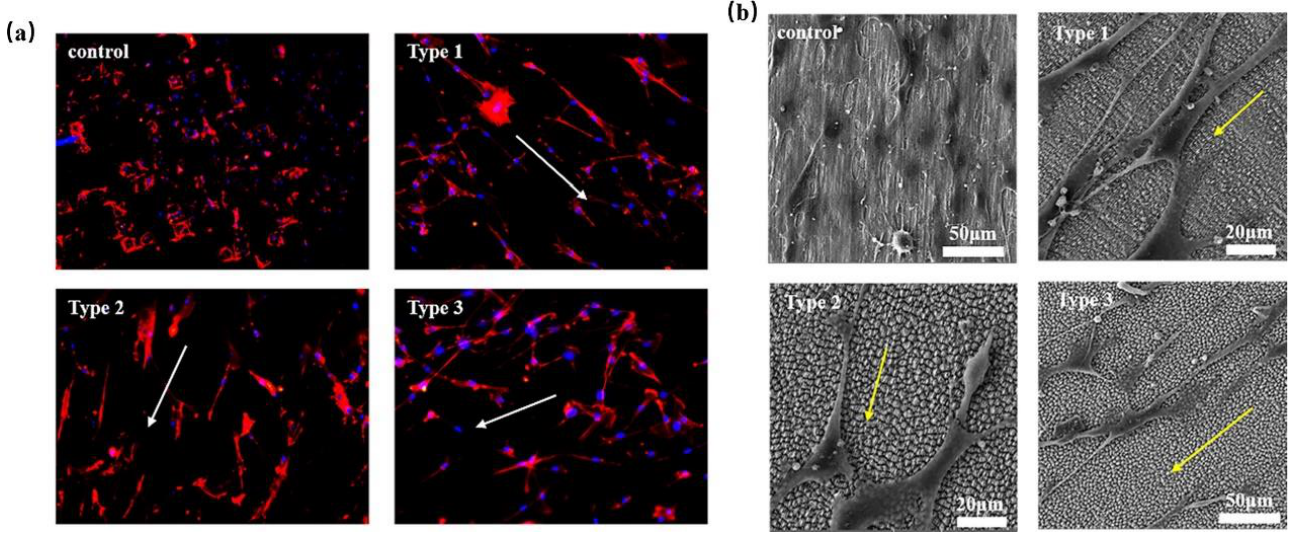
Figure 10. Ref. [103] Mesenchymal stem cells ’ adhesion on the polished surfaces and three types of nano-ripples after 72 h of incubations. ( a ) Fluorescence images of cytoskeletons; ( b ) SEM images of MSCs ’ adhesion states for the three types of nano-ripples. The both arrow indicates the direction of cell diffusion